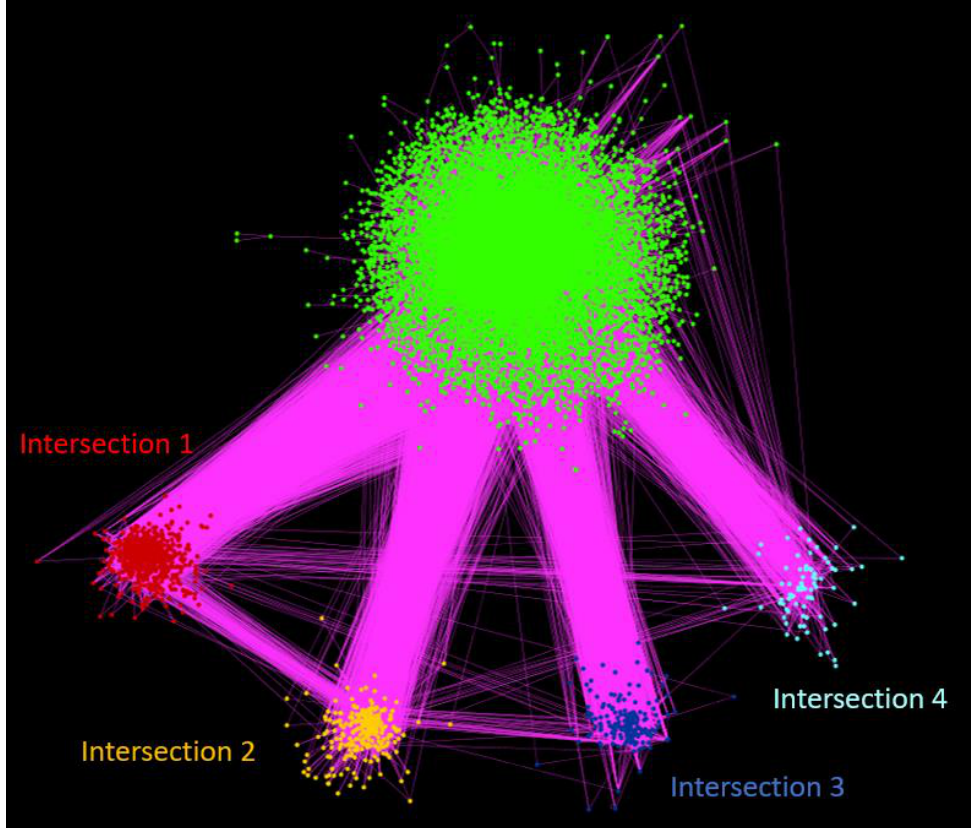
Figure 4. The four largest intersections between clusters of the two clustering methods, RW and N2V-HC, applied on the full PICKLE 3.2 PPI network. These groups of nodes represent densely connected neighborhoods of the human protein interactome, referring to concrete biological functions. Red, yellow, blue, and light blue dots represent the protein-node sets of intersections 1 (RW Cluster 5 // N2V-HC Cluster 2), 2 (RW Cluster 8 // N2V-HC Cluster 3), 3 (RW Cluster 10 // N2V-HC Cluster 8), and 4 (RW Cluster 13 // N2V-HC Cluster 10), respectively, ranked by size. Green dots represent the rest of the protein-nodes of PICKLE 3.2 interactome. Full protein list for the four intersections is provided in Supplementary Table S7.